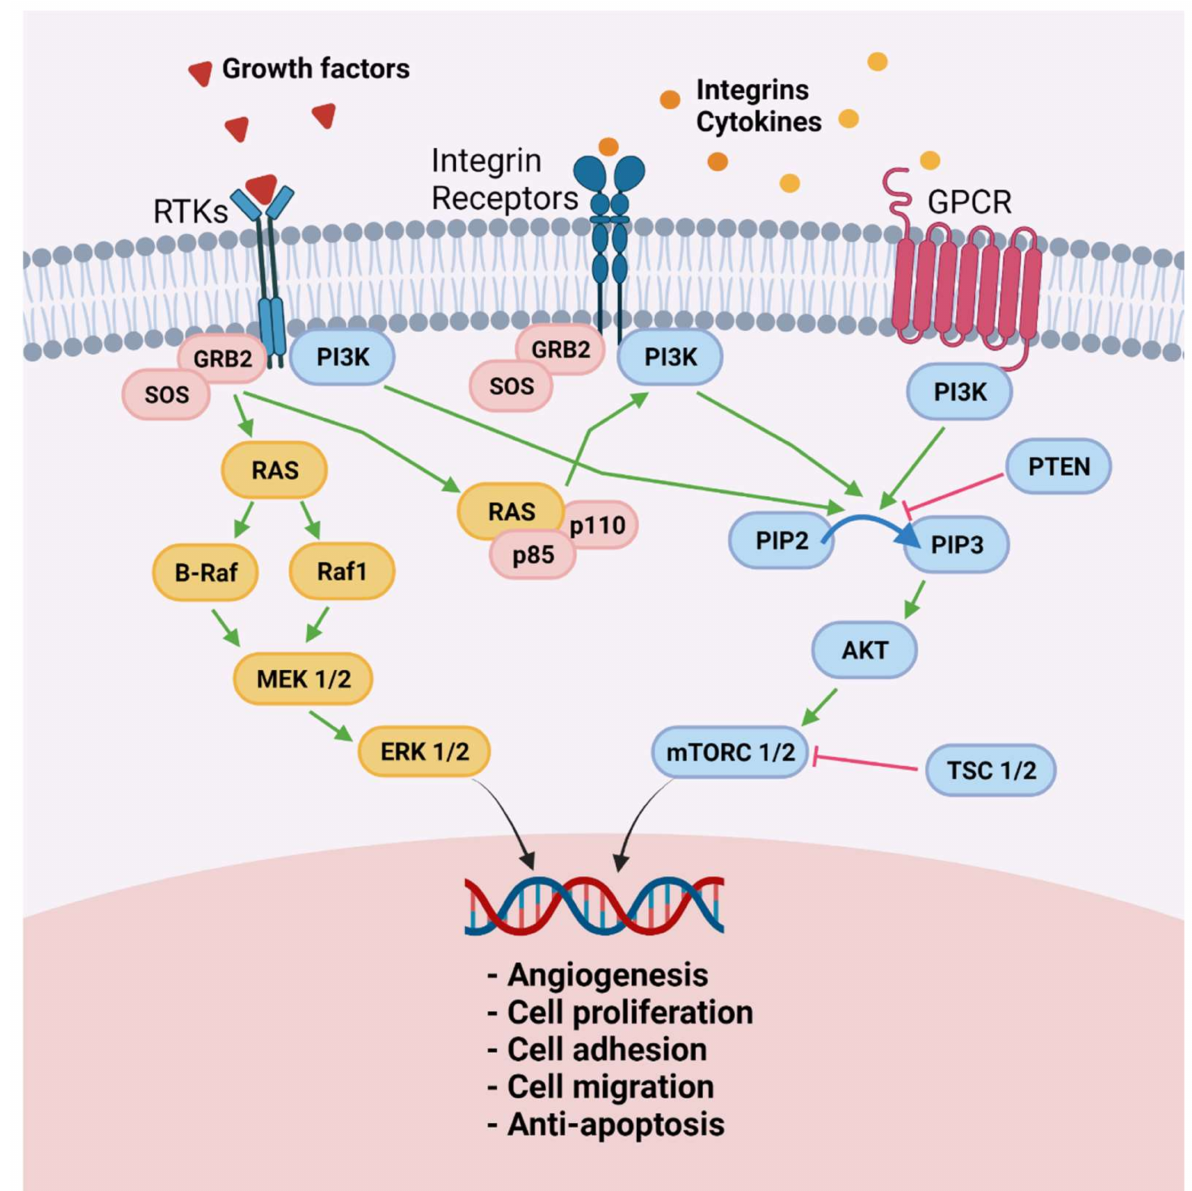
Figure 2. Raf/MEK/ERK and PI3K/Akt/mTOR pathways in ectopic endometrial cells. Molecule-like growth factors, integrins, and cytokines that bind to receptors on the cell surface activate both the Raf/MEK/ERK and the PI3k/Akt/mTOR signaling pathways in endometrial cells to acquire proangiogenic features, proliferation ability, increased adhesion and migration capacity, and resistance to apoptosis: RTKs, receptor tyrosine kinases; GRB2, growth factor receptor-bound protein 2; SOS, son of sevenless; Raf, serine/threonine-protein kinase; MEK 1 , mitogen-activated protein kinase; ERK 1 , extracellular 2 2 signal-regulated kinase; GPCR, G protein-coupled receptor; PI3K, phosphoinositide 3 kinase; PTEN, phosphatase and tensin homolog; p110; p85 PIP2, phosphatidylinositol 4,5-bisphosphate; PIP3, phosphatidylinositol 3,4,5-trisphosphate; Akt, protein kinase B; mTORC1, mammalian target of rapamycin complex 1; TSC 1 , tuberous sclerosis complex 2. Created with 2 biorender.com (accessed on 28 May